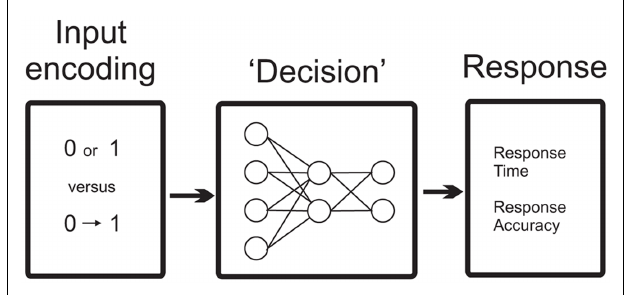
FIGURE 2 | Information flow in the basic model. The Decision stage consists of the Cohen et al. (1990) model of Stroop processing.The continuous stage simulations reported here use this architecture, merely with modifications to the input